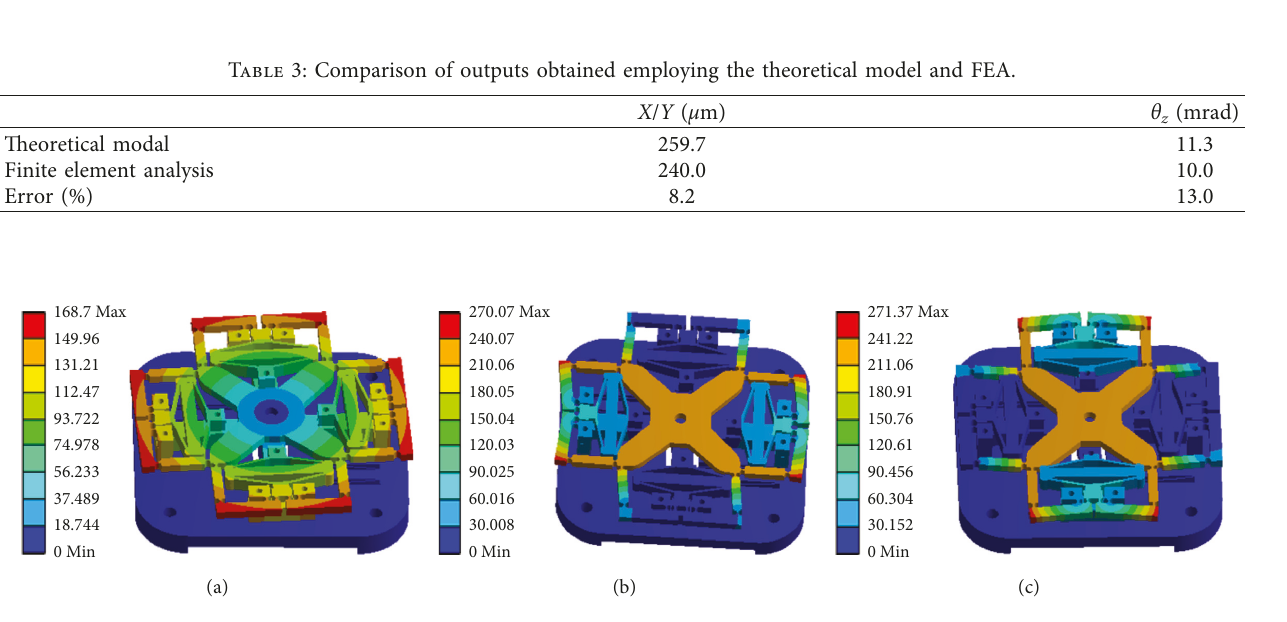
z direction, (b) Y direction, and (c) X